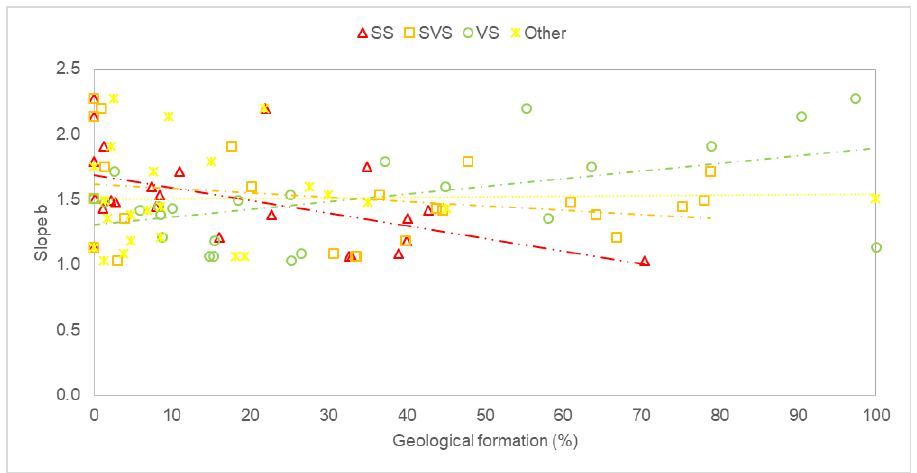
Figure 5. Relationship between geological formations (%) and the slope 𝑏 . “Other” plots indicate the sum of intrusive and metamorphic formations.